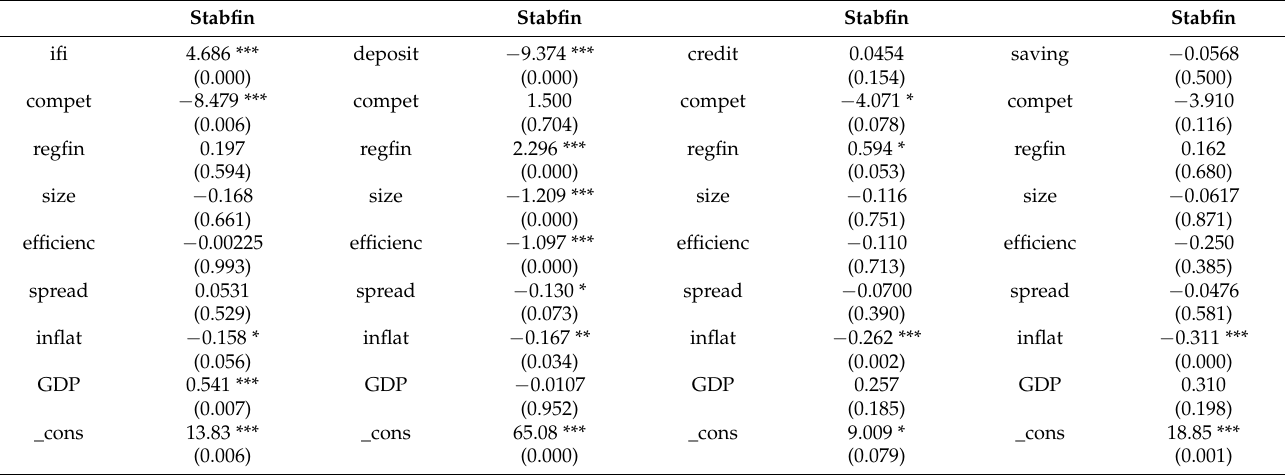
Table 9. Effect of financial inclusion on financial stability in LAC